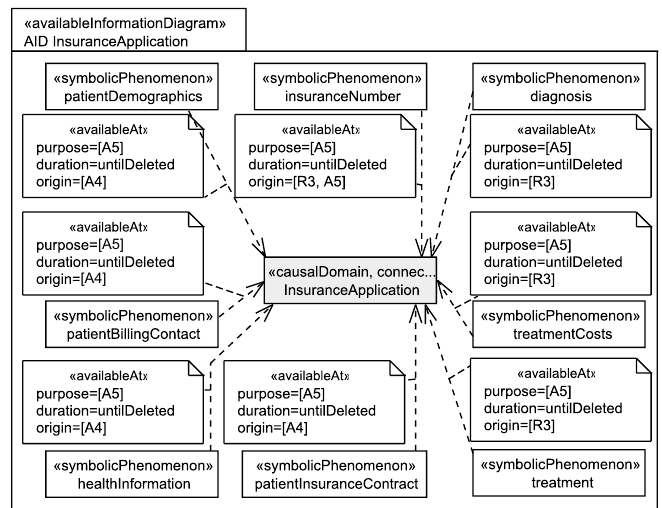
Figure 7. View on the available information diagram for the insurance application showing the which personal data of patients are available at the insurance application.